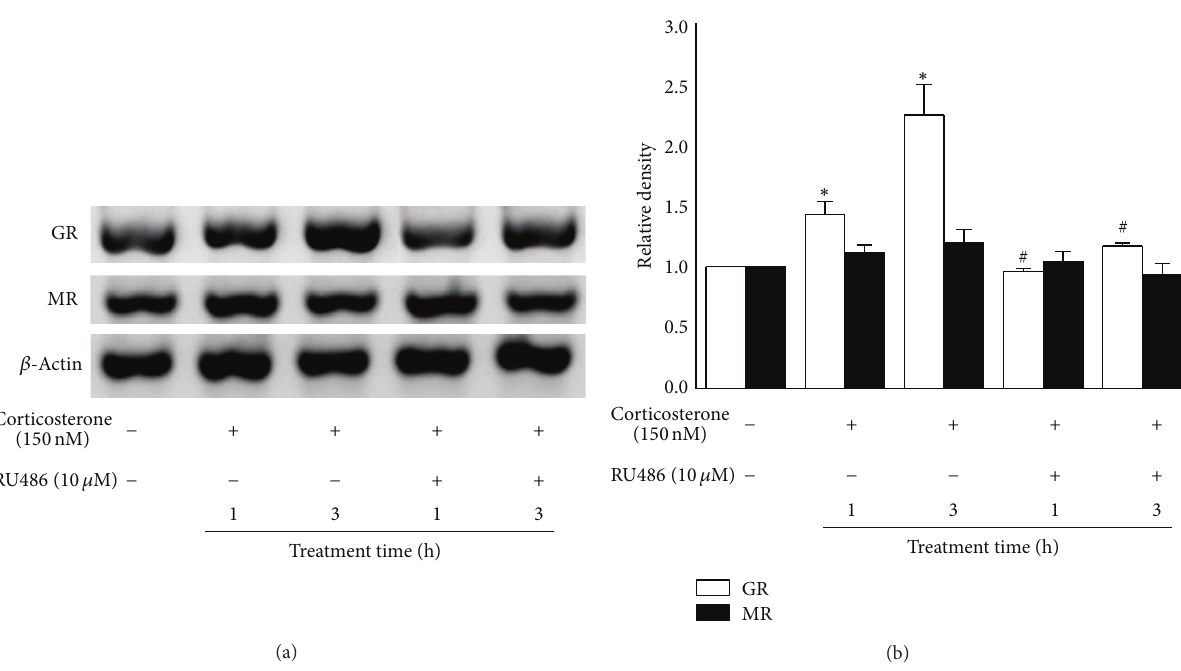
Figure 5: Effects of low concentration of corticosterone on the expression of GR and MR protein in rat peritoneal macrophages. (a) The expression of GR and MR protein was detected by Western blot assay. 𝛽 -actin was used as loading control. (b) Relative levels of GR and MR protein in rat peritoneal macrophages after treatment with corticosterone (150nM) and RU486 (10 𝜇 M). The bars represented the mean ± SD ( 𝑛 = 3 ). ∗ 𝑃 < 0.05 versus the control group; # 𝑃 < 0.05 versus macrophages treated with corticosterone (150nM) for the corresponding